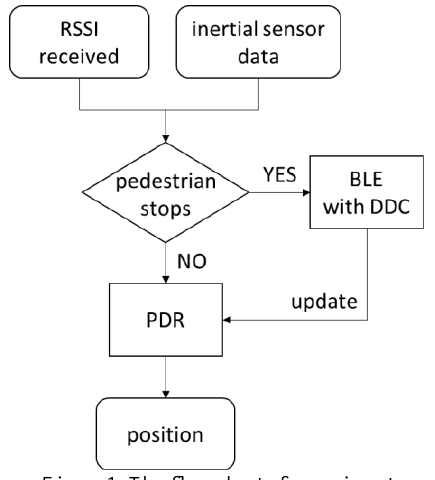
Figure 1. The flow chart of experiment